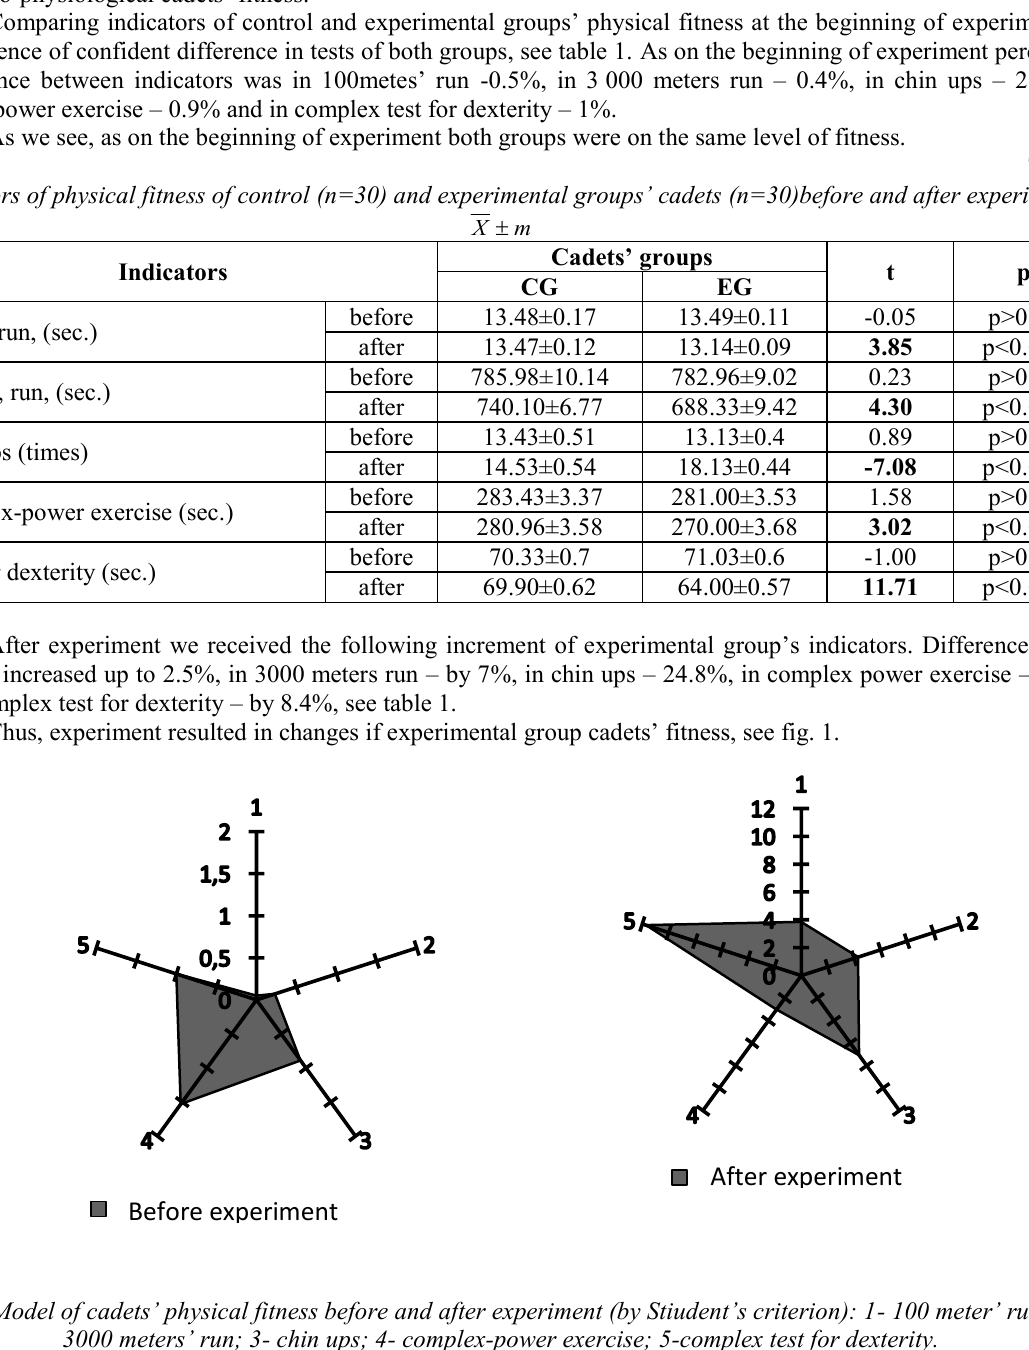
Fig.1. Model of cadets’ physical fitness before and after experiment (by Stiudent’s criterion): 1- 100 meter’ run; 2- 3000 meters’ run; 3- chin ups; 4- complex-power exercise; 5-complex test for